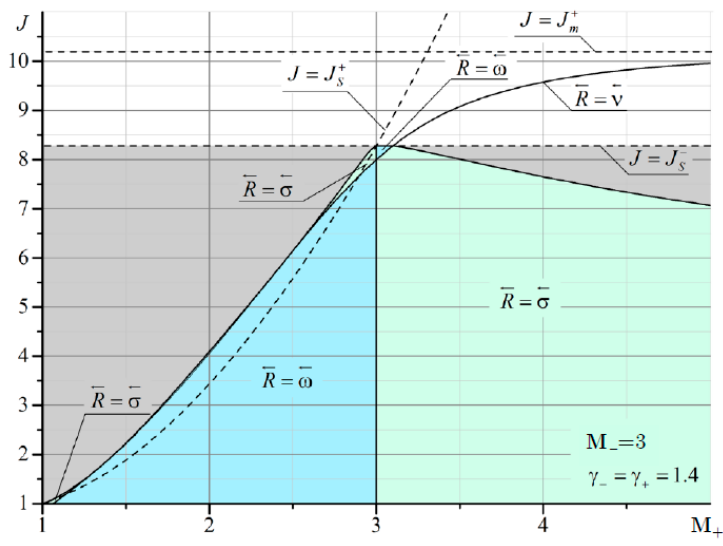
Figure 12. Domains of existence of various types of hydrocarbons formed during refraction of a shock with intensity J , propagating from a flow with a Mach number M – = 3 into a flow with a Mach number M + .